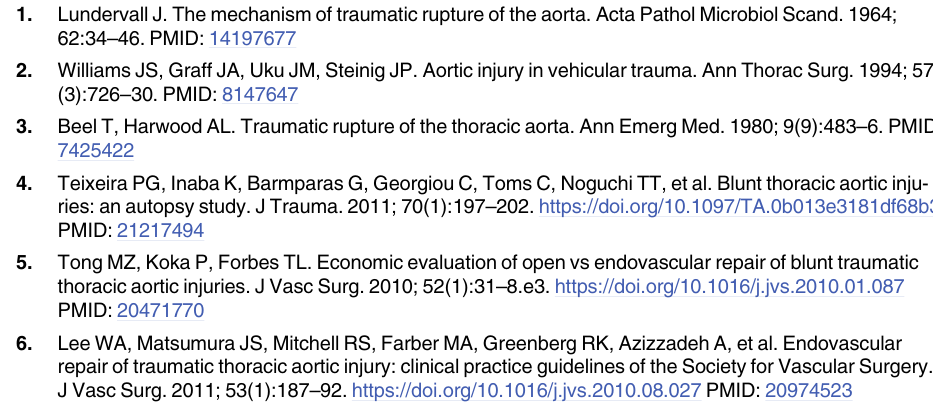
S1 Fig. Data extraction of the raw data delivered by the